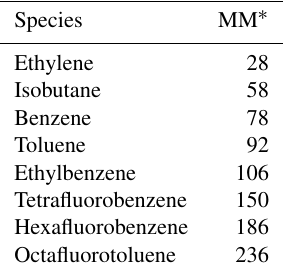
Table A2. Compounds and their molecular masses in the Syft 2ppm standard gas, which was used to generate the daily instrument cali- bration factor